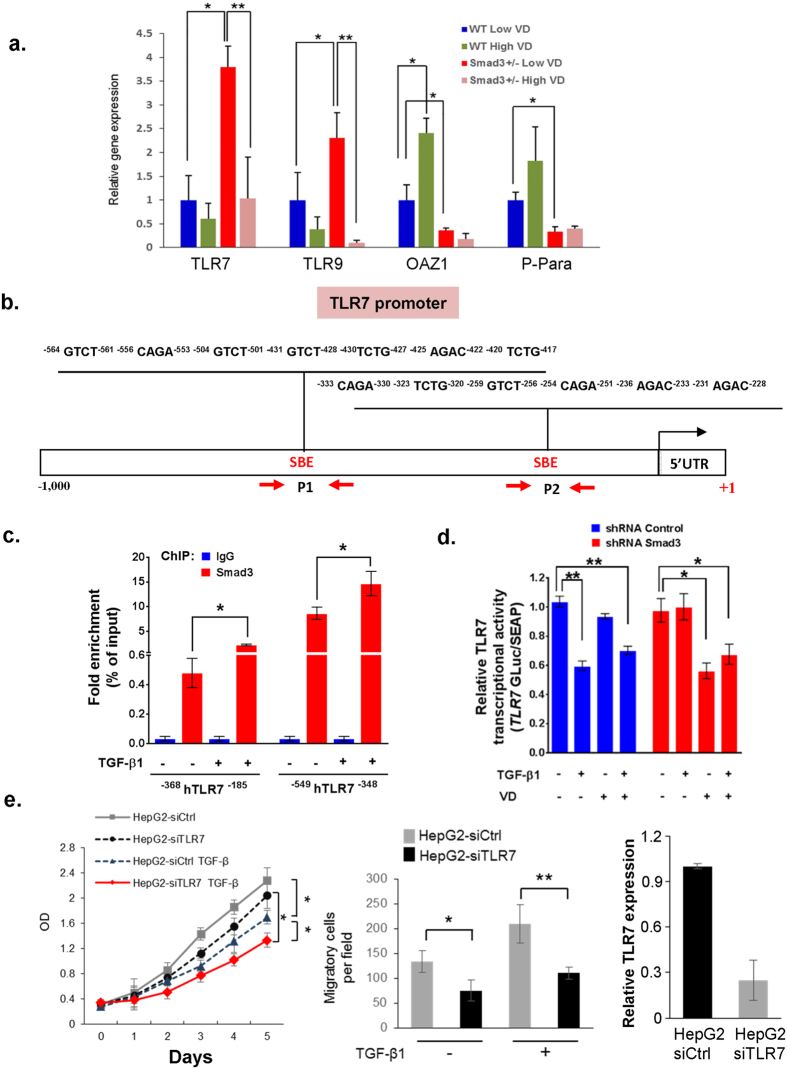
TLR7 is a downstream target of TGF-β/Smad3 and VD signaling.(a) Total mRNA was isolated from liver tumors of both wild type and Smad3+/− mice which were fed either low VD or high VD regimen (n = 3 for each group). Gene expression levels of TLR7, TLR9, OAZ1, and P-Para were measured by Q-PCR. Each result shown is representative of three independent experiments. Error bars are shown as standard deviations. (*p < 0.05 [WT Low VD vs. Smad3+/− Low VD], **p < 0.05 [Smad3+/− Low VD vs. Smad3+/− High VD], Student’s t-test). (b) A schematic representation of the TLR7 promoter studied by ChIP analysis. Two sets of PCR primers, designated as P1 and P2, were used for amplification of the TLR7 promoter. SBE (Smad-binding element) positions are numbered relative to the major transcription start site (+1). Black arrow indicates transcription start site. (c) HepG2 cells were treated with 200 pM TGF-β for 2 hrs. ChIP experiments were performed as described in Methods. (d) Gaussia luciferase plasmid containing a TLR7 promoter region was transfected into HepG2 shRNA-Control and HepG2 shRNA-SMAD3 cells. The secondary reporter, secreted Alkaline Phosphatase, serves as an internal control. TLR7 transcriptional activity was analyzed after 200 pM TGF-β and 100 nM VD treatment for 24 hrs. Error bars are shown as SD in (c,d). Each result shown is representative of three independent experiments (*p < 0.01, **p < 0.001, Student’s t-test). (e) Knockdown TLR7 suppresses HepG2 cell growth and cell migration. Cell proliferation of HepG2-siCtrl and HepG2-siTLR7 cells were assessed by colorimetric MTS assays. Transwell migration assays of HepG2-siCtrl and HepG2-siTLR7 cells were performed. Cells were treated with TGF-β1 (200 pM) for 24 hours. HepG2 cells were transfected with control-siRNA or TLR7-siRNA. The expression of TLR in HepG2-siCtrl and HepG2-siTLR7 cells were measured by Q-PCR analyses. Results are presented as mean ± SD (*p < 0.05, **p < 0.01, Student’s t-test).